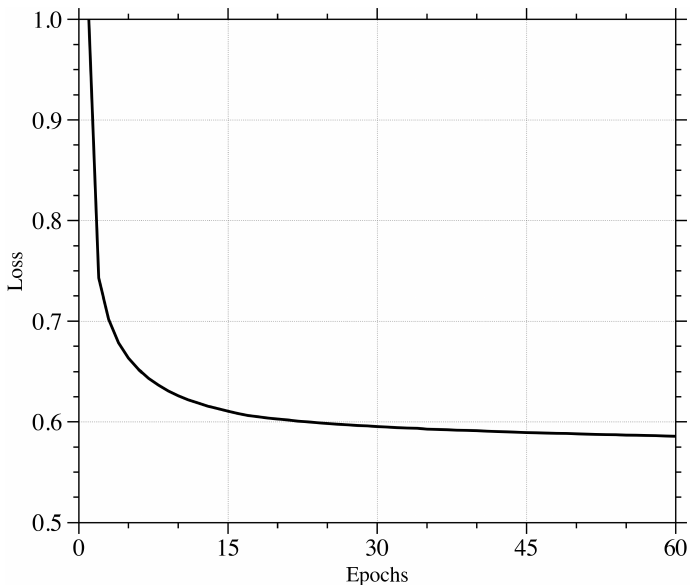
Fig. 2: Variations of the loss function with respect to the epochs in the NN training. Figure 2. Variations of the loss function with respect to the epochs in the NN